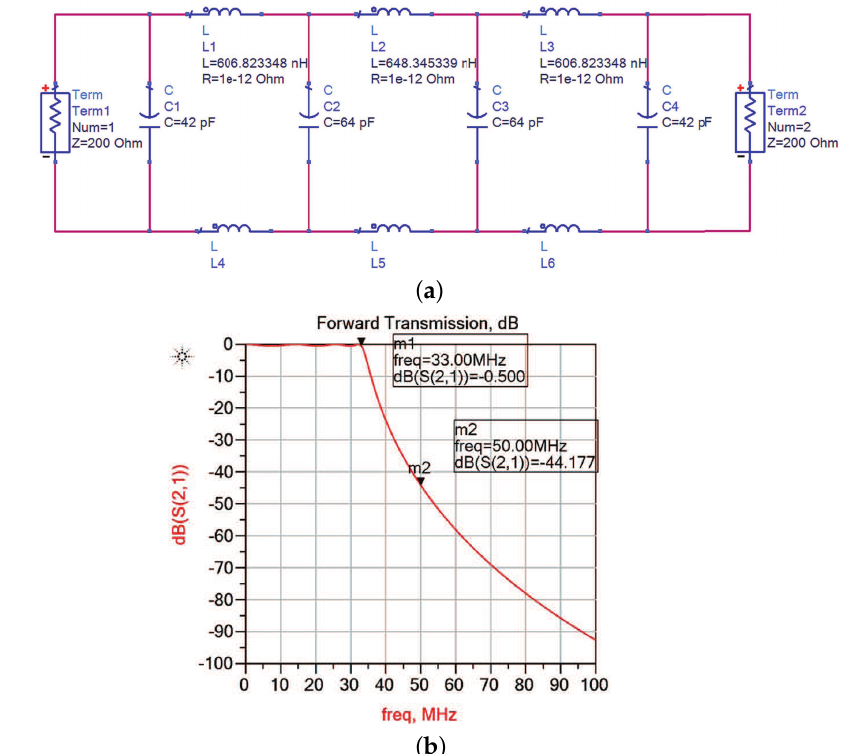
Figure 8. The circuit diagram ( a ) and frequency characteristic ( b ) of low-pass filter (LPF).